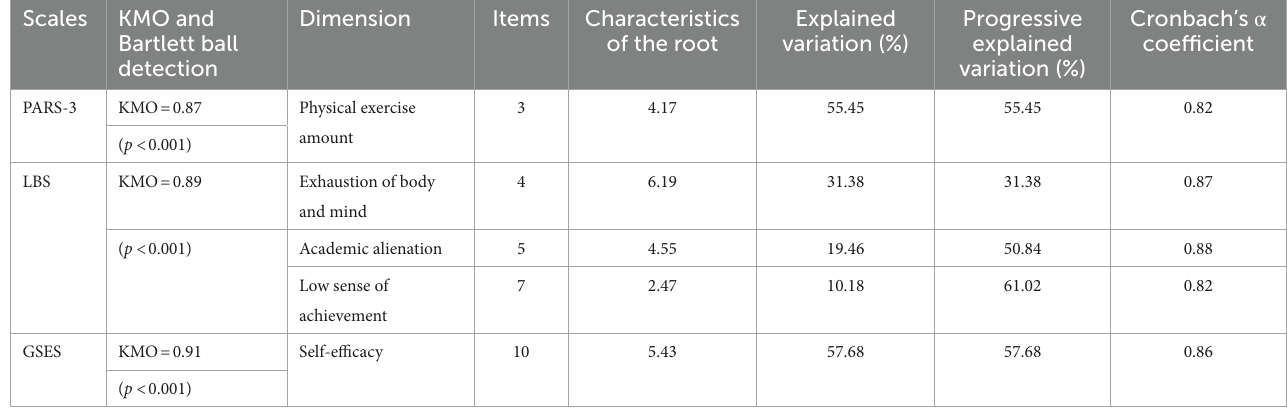
TABLE 1 Factor extraction and reliability analysis of the three measurement scales. Scales KMO and Bartlett ball detection